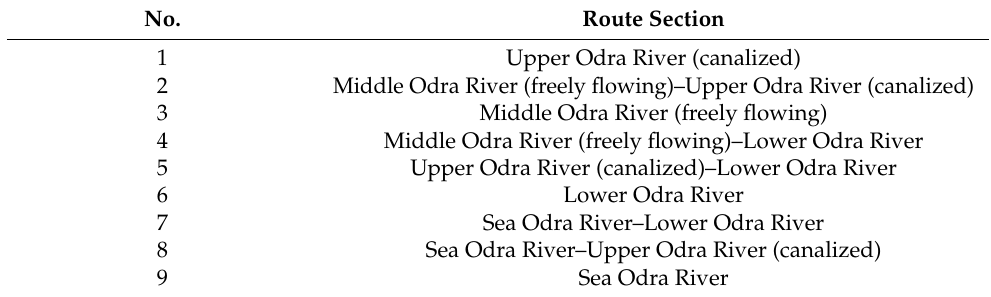
Table 3. Sections of the Odra River. No. Route